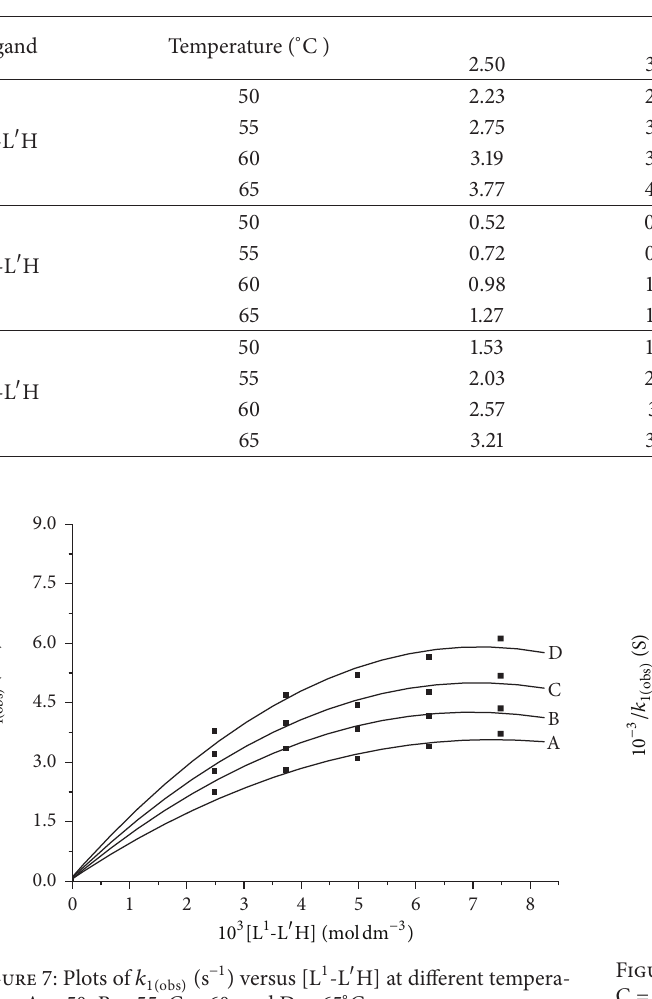
Table 1: 10 3 𝑘 1( (s − 1 ) values for different dipeptide concentrations at different temperatures; [Complex A ] = 2.5 × 10 − 4 moldm − 3 , pH = 4.3, obs ) . ionic strength = 0.1 moldm − 3 NaClO 4